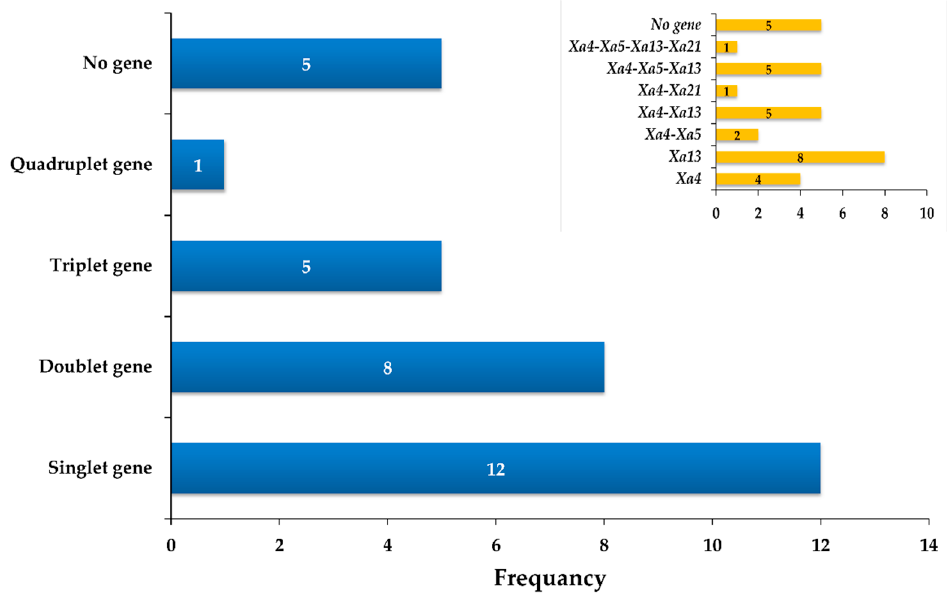
Figure 5. Combination and frequency of Xa genes in RILs of rice.